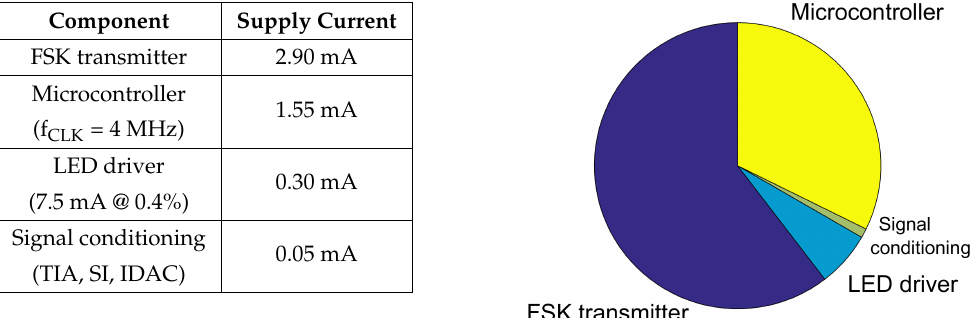
Figure 7. Distribution of power consumption drawn from a 2.5 V source by the PPG readout